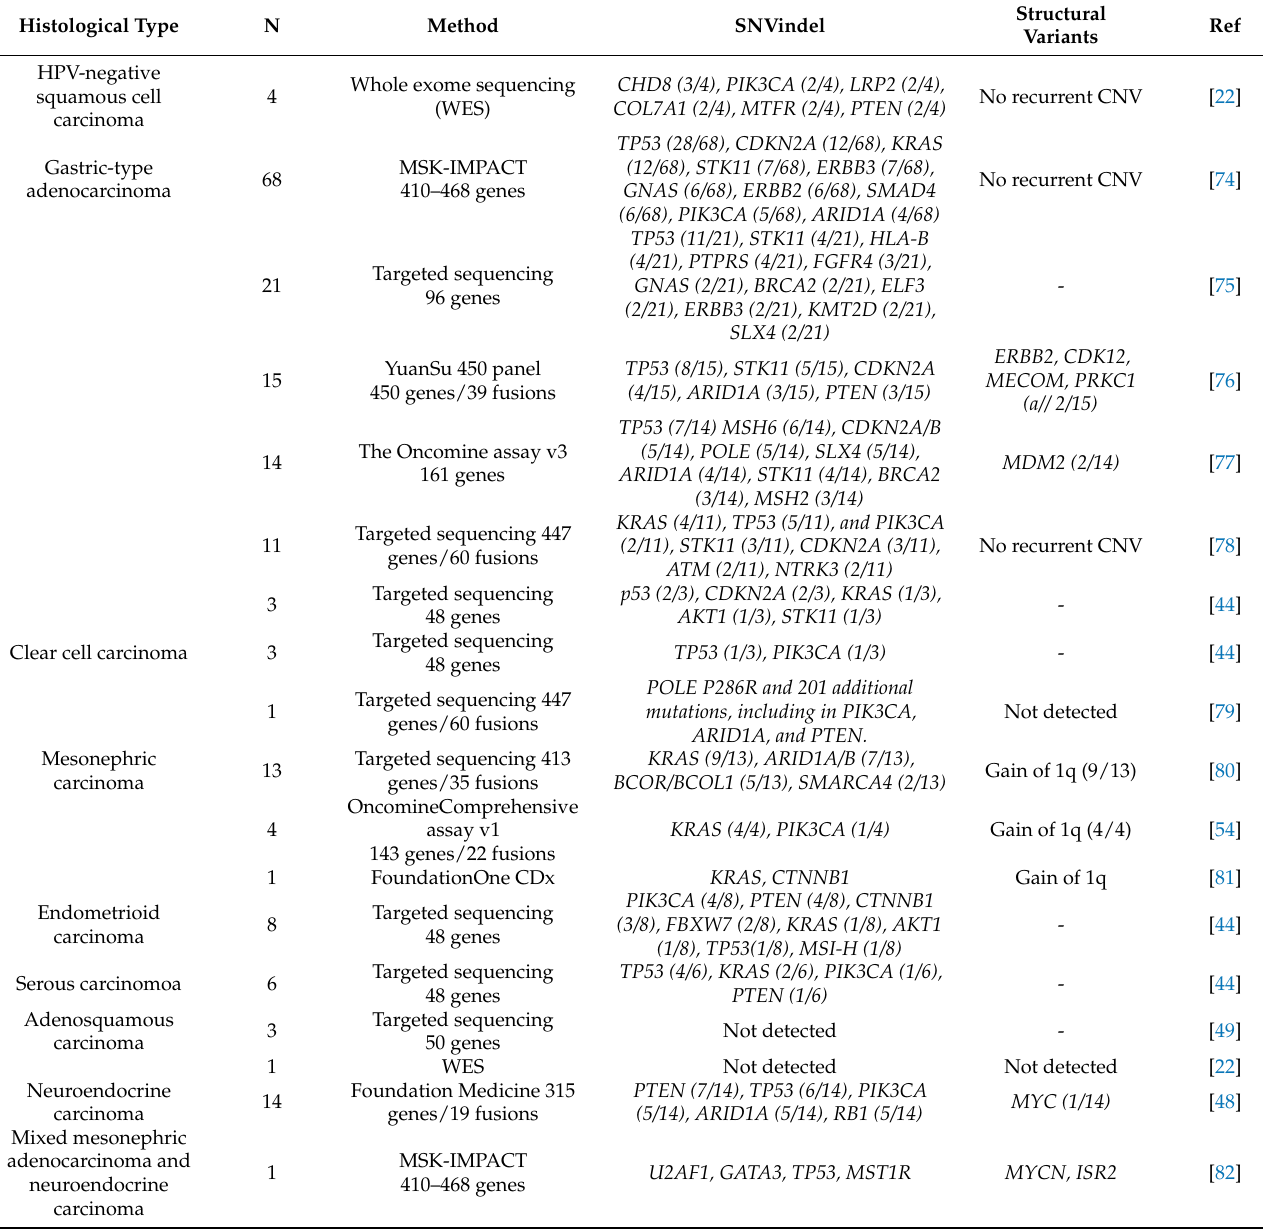
Table 5. Reported genetic alterations in HPV-negative cervical cancer of each histological